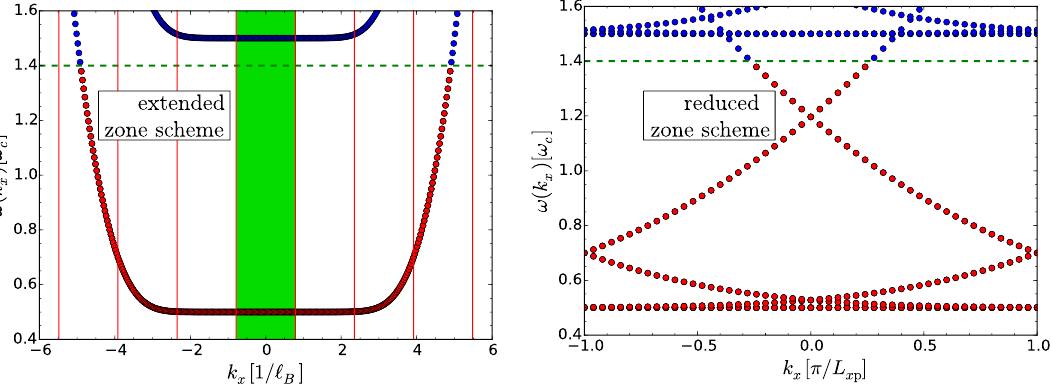
Figure 7: Left panel: Zoom of the lowest eigen energies in the extended zone scheme for = 10 µ m and L = 4.01 µ m. (the deviation from 4 µ m is only due to the discretization). L y x p Red symbols corresponds to occupied states while blue symbols represent unoccupied states. The horizontal dashed green line indicates the chosen Fermi energy. The thin vertical red lines show boundaries of the corresponding reduced zone scheme. By backfolding the energies into the green shaded area one obtains the representation of the reduced zone scheme which is shown in the right